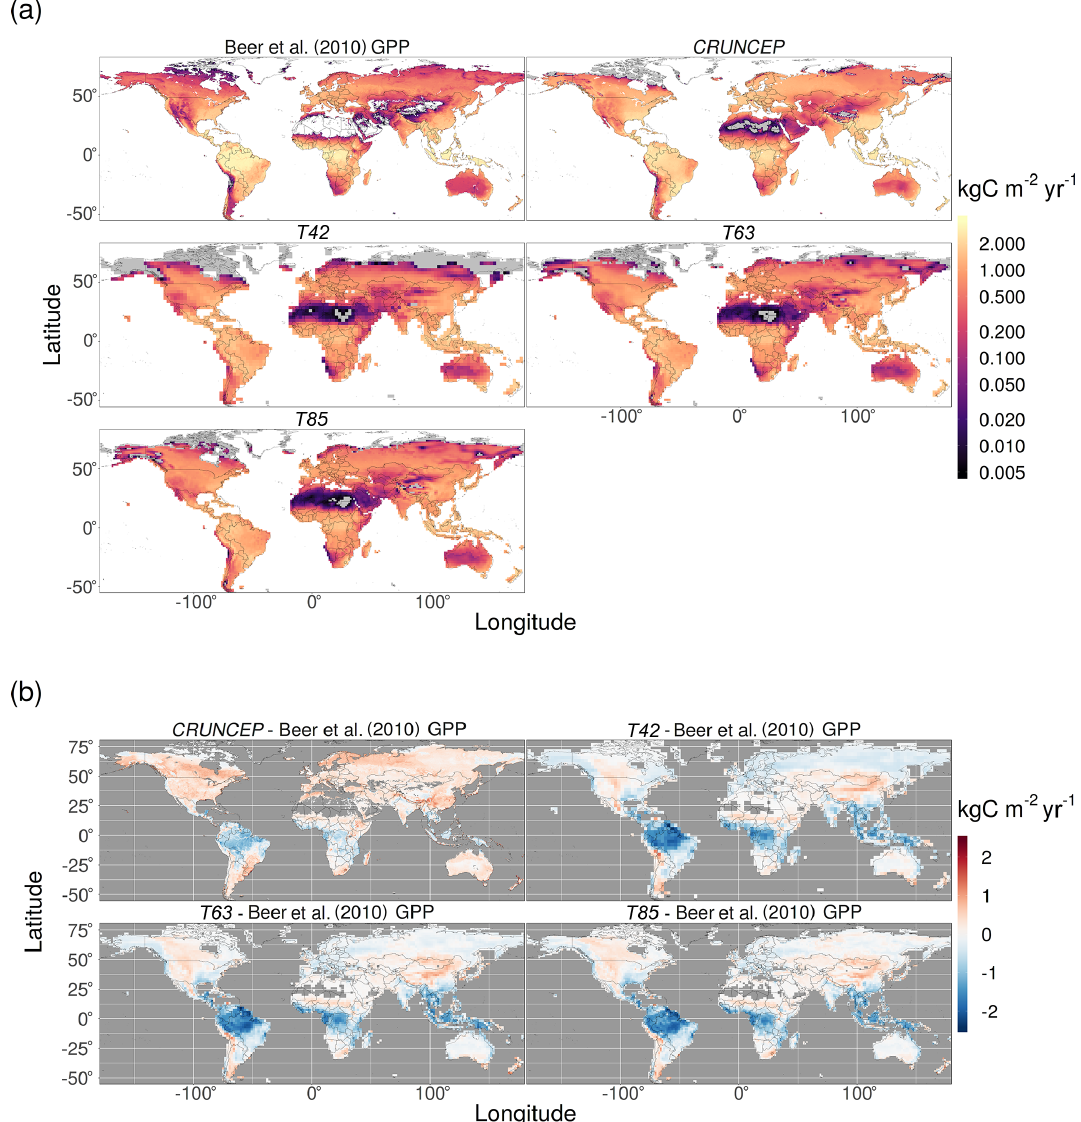
Figure 3. Comparison of GPP from the T42 , T63 , and T85 (EMAC climate) and CRUNCEP (observed climate) simulations with the gridded GPP product from Beer et al. (2010); (a) absolute values and (b) the difference between simulations minus observations. In (a) , the colour scale has been log-transformed, and grey areas denote GPP values less than 5gCm − 2